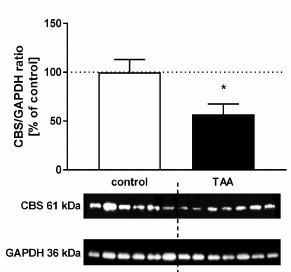
Figure 4. The relative protein level and representative immunoblot of cystathionine β -synthase (CBS) (61 kDa) in the cerebral cortex of control and TAA rats. The graph represents data normalized to GAPDH (36 kDa) and expressed as a percentage of control. Data are reported as mean ± SEM, n = 3–6. * p < 0.05 compared with